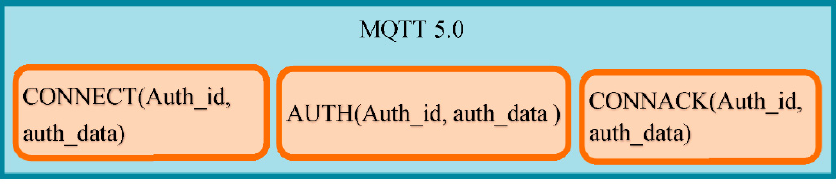
Figure 1. Protocol stack of MQTT 5.0-enhanced authentication.